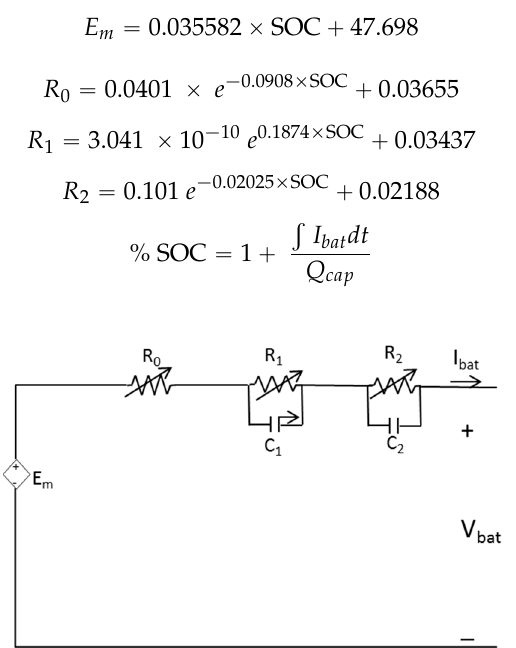
Figure 5. Lithium ‐ ion battery model. Figure 5. Lithium-ion battery